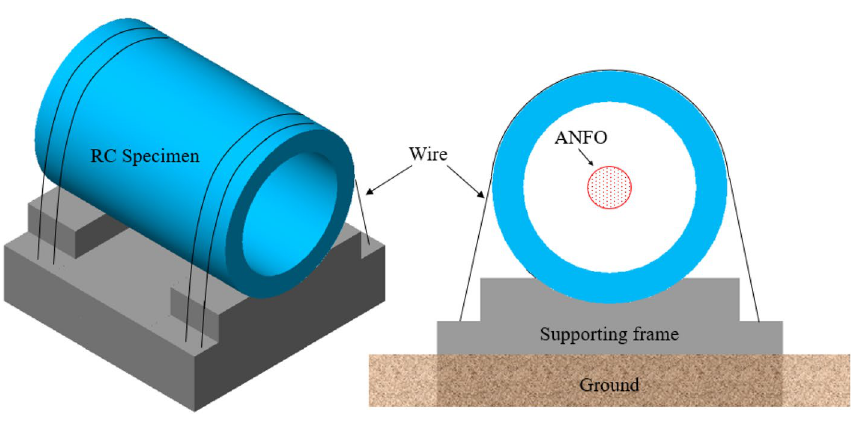
Figure 3. Details of supporting